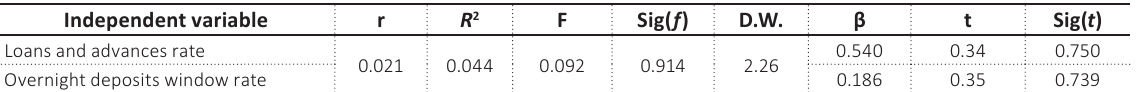
Table 5. Multiple linear regression for testing the effect of the Central Bank of Jordan on capital adequacy ratio in the banks working in Jordan (2005–2011)